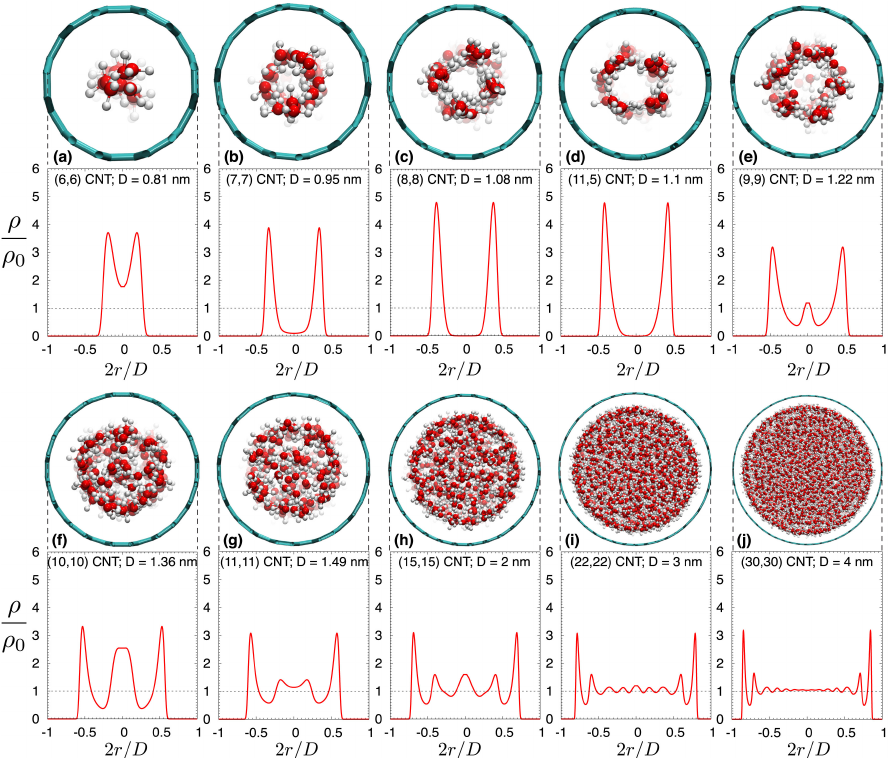
Figure 4. ( a – j ): Radial density profiles and MD cross-section snapshots of the confined water molecules at increasing CNT diameters. The axes have been normalized by bulk density ρ 0 = 1000kgm − 3 , and carbon- to-carbon radius D/2, where D is the diameter of the CNT. Reprinted with permission from Ref.